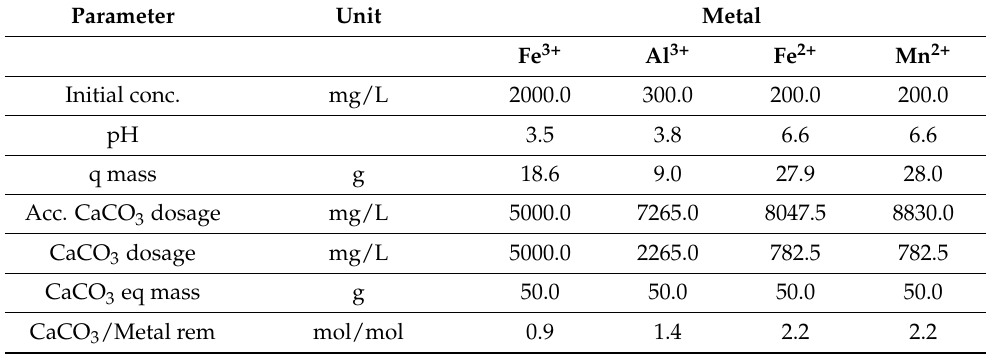
Table 8. Mole ratio of Alkali dosage/Metals removed at 1 atm.